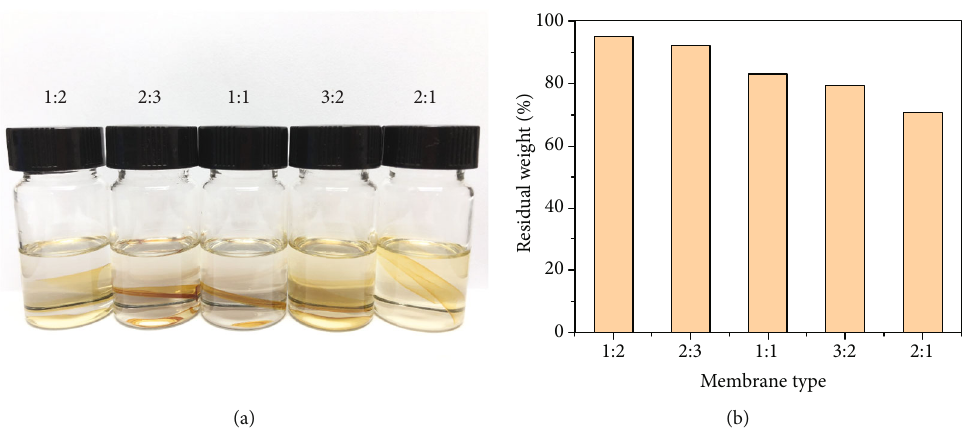
Figure 3: Gel fraction test of PEI-ER/PBI membranes performed in NMP at 80 ° C for 12 h. (a) The membrane samples in NMP at 80 ° C after 12h and (b) the residual weight of the membranes after solvent treatment.